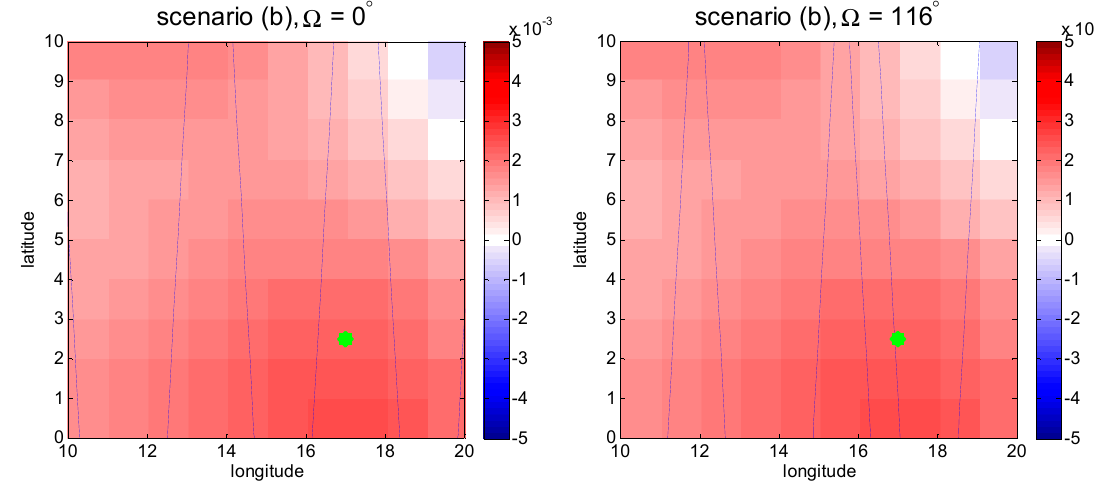
Figure 20. Groundtrack of the scenario (b) over West-Africa for left : Ω = 0°, and right : Ω = 116° (where sub-cycle happens).